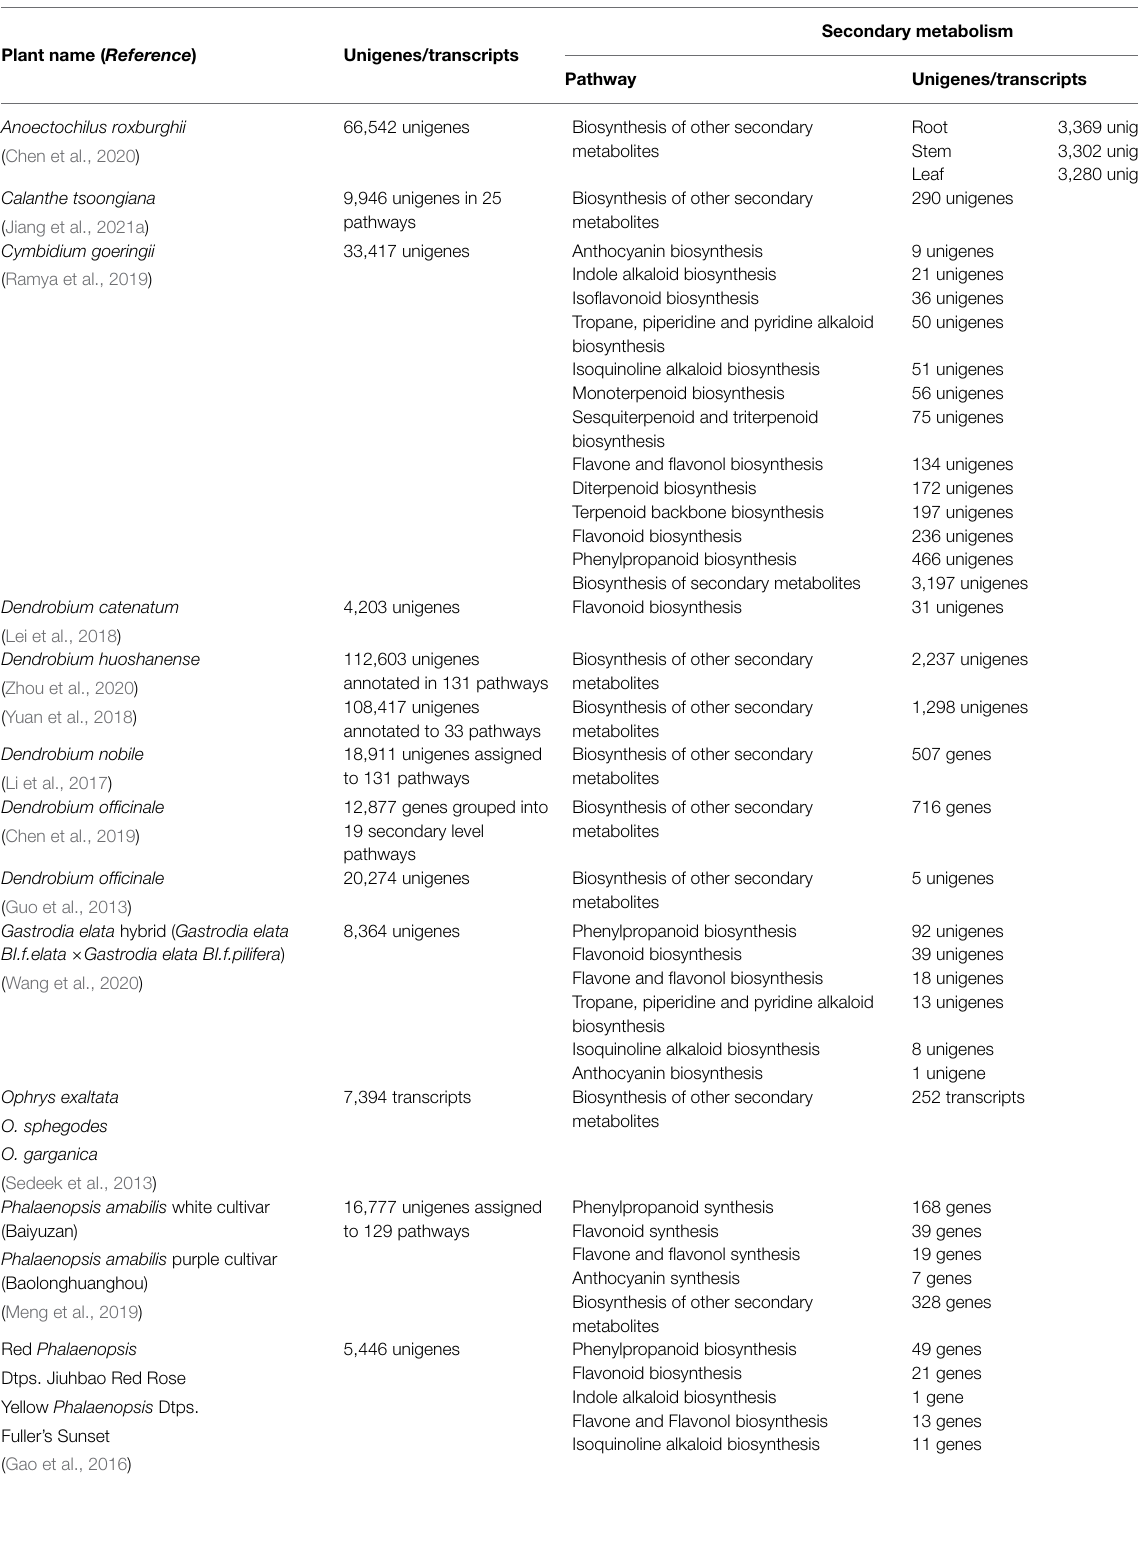
TABLE 3 | KEGG pathway analysis of secondary